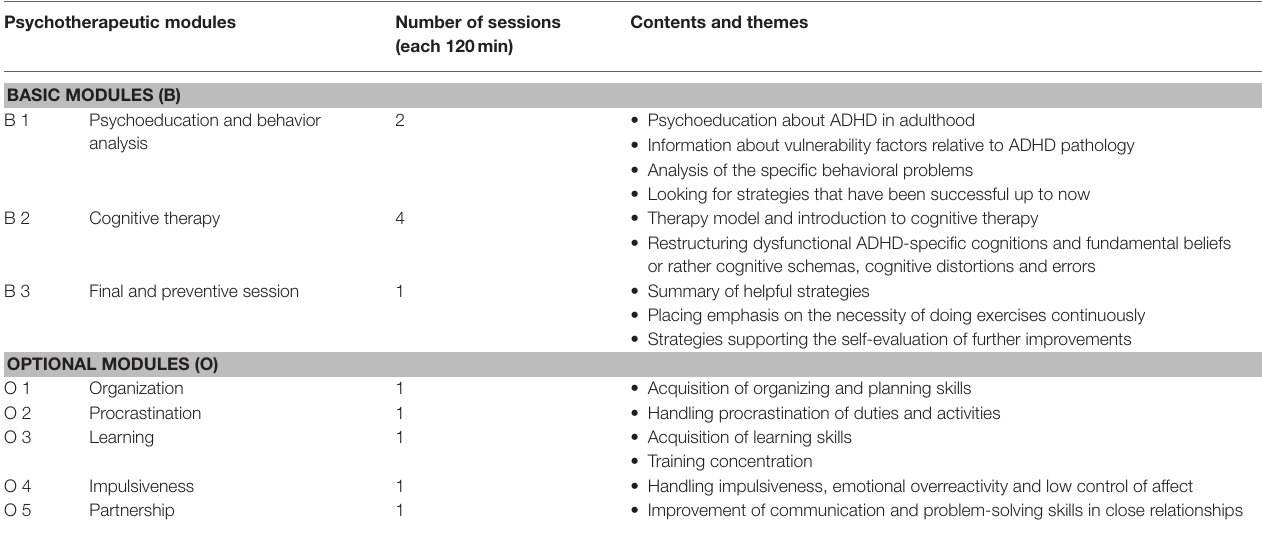
TABLE 1 | Overview of the psychotherapeutic modules. Psychotherapeutic